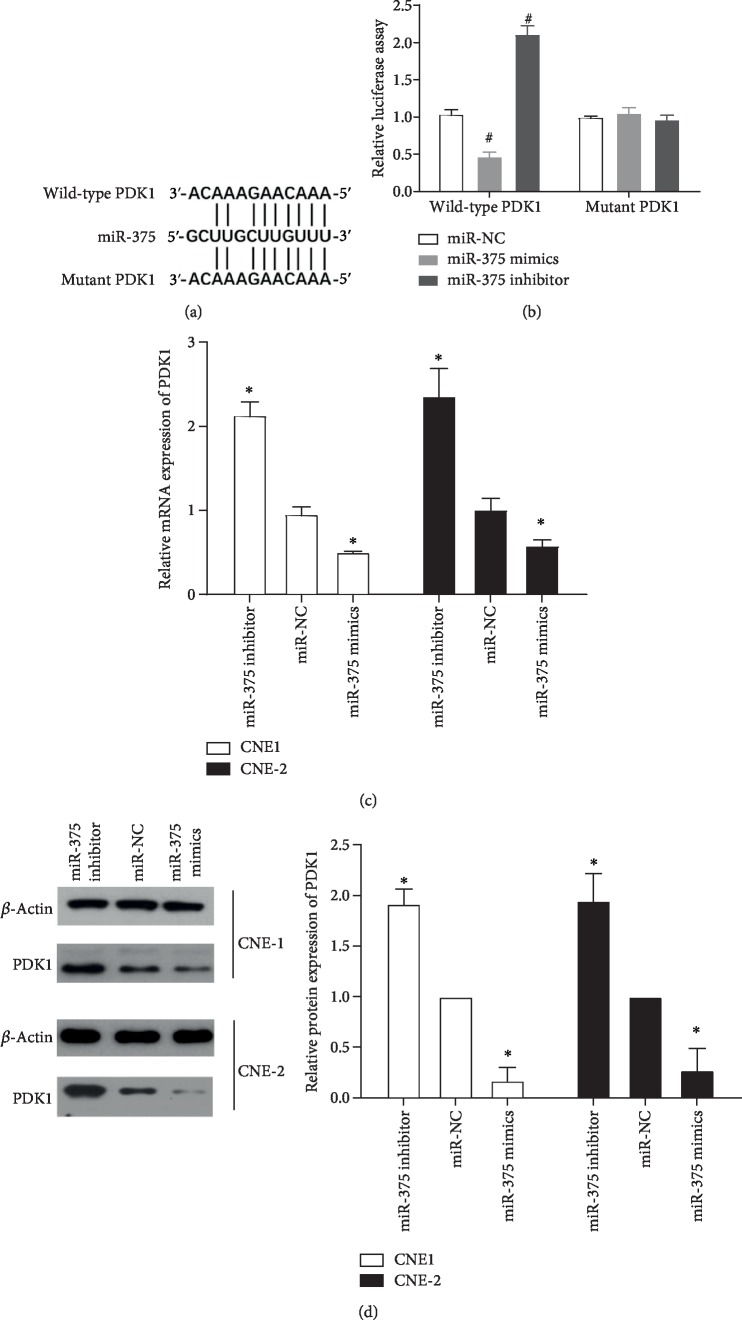
PDK1 is a direct and functional target gene of miR-375. (a) miR-375 was sequenced to reflect the positioning of PDK1 3′-UTR seed regions and associated mutations. (b) The dual-luciferase reporter assay was performed with the pmirGLO dual-luciferase vector in CNE-2 cells. Detection of relative levels of PDK1 mRNA (c) and protein (d) expression in CNE-1 and CNE-2 cells transfected with miR-375 mimic or inhibitor, as determined by qRT-PCR and Western blot. ∗P < 0.05 vs. miR-NC.